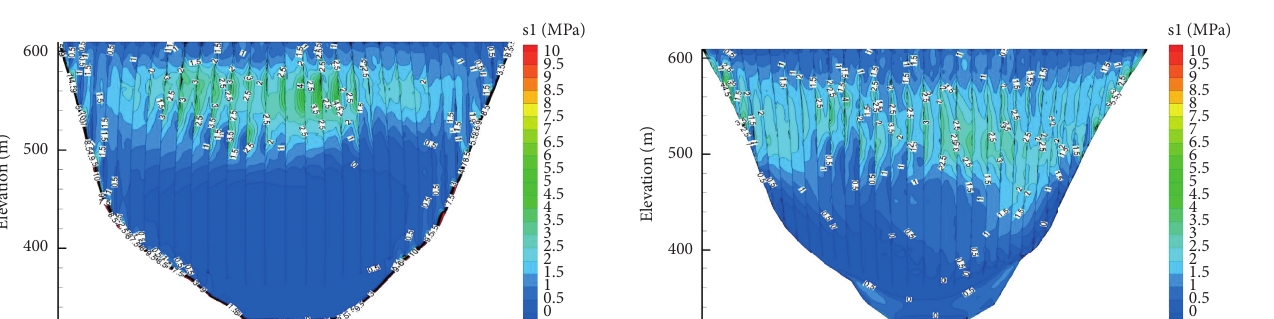
Figure 21: Envelope of maximum principal tensile stress distri- bution of upstream surface of the dam for relative sliding condition.